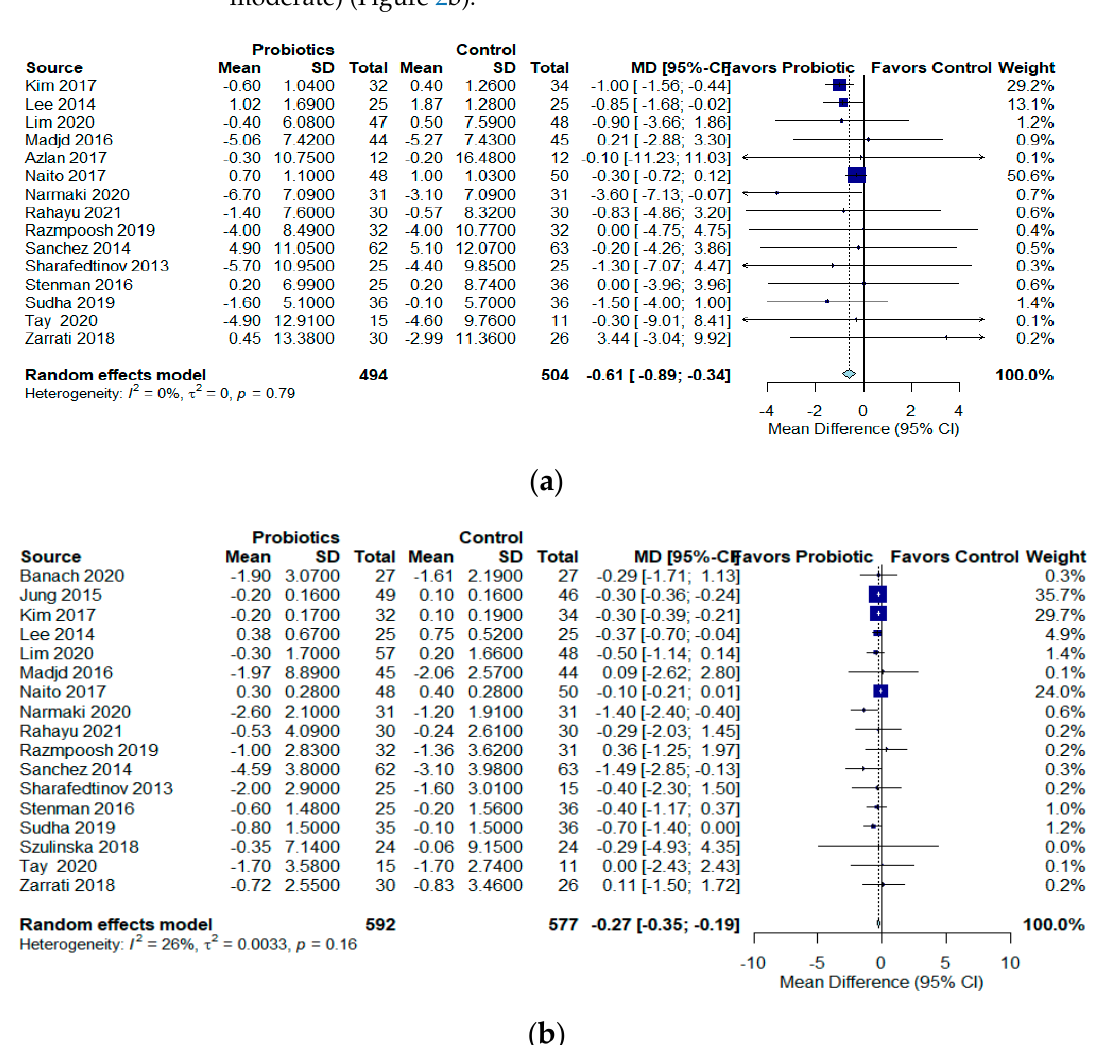
Figure 2. Effects of probiotics on ( a ) Weight in kg, and ( b ) BMI in kg/m 2 .